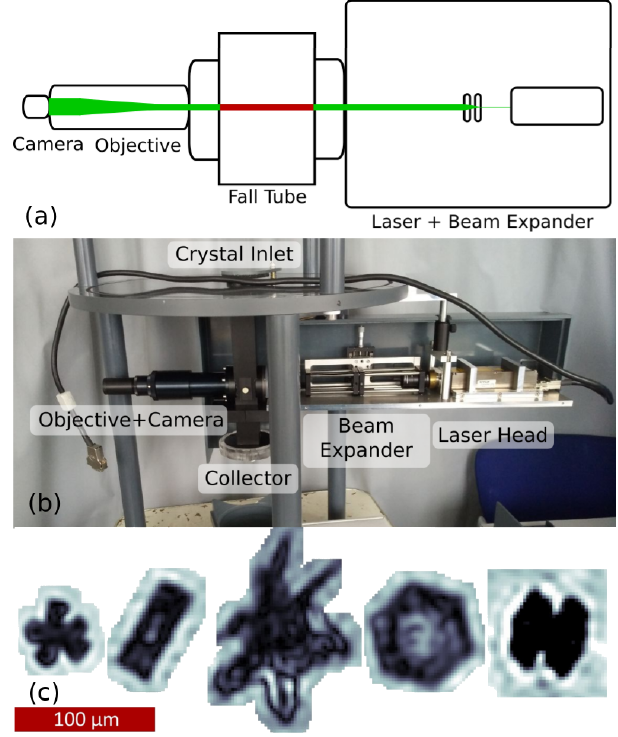
Figure 2. The HIVIS instrument used for holographic imaging. (a) Sketch of top-down view (sample volume in red), (b) photo- graph taken from the side, and (c) sample reconstructed images of ice crystals recorded by the HIVIS